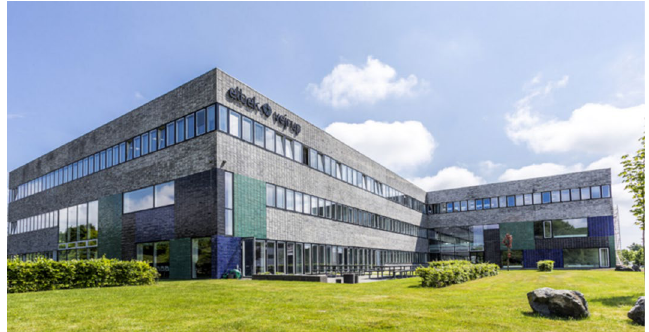
Fig. 4 IoT Test Lab Tangen in Denmark